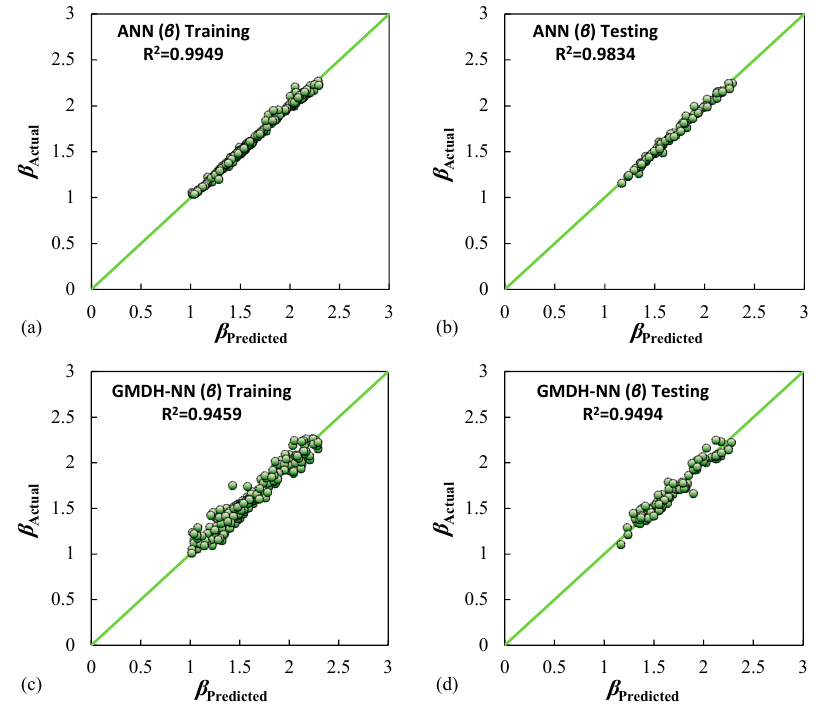
Figure 17. Measured vs. predicted β for training and testing stages using: ( a ) and ( b ) ANN ( β ); ( c ) and ( d ) GMDH-NN ( β )